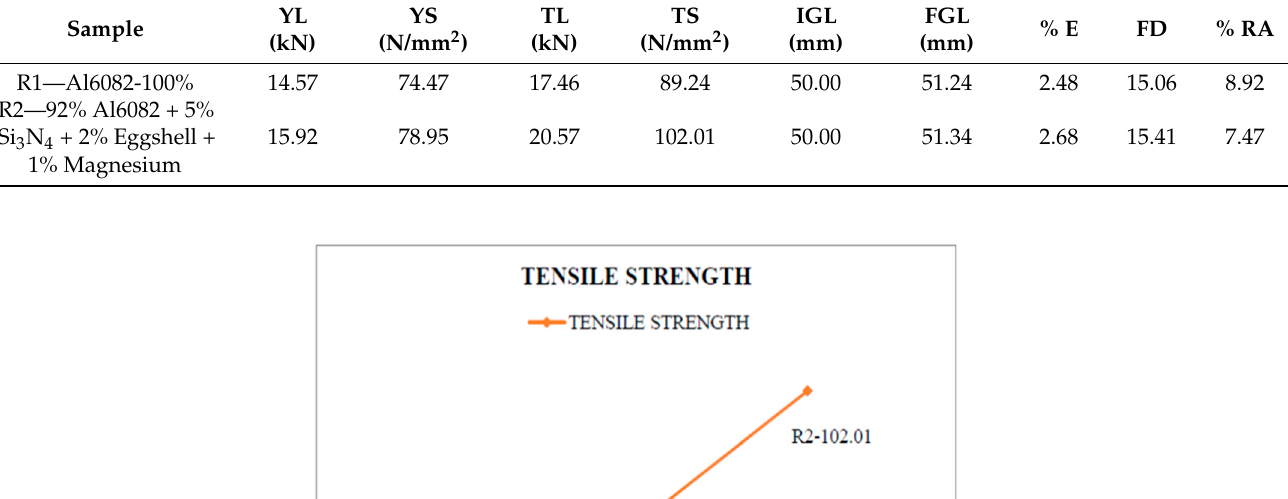
Table 5. Tensile strength test value.